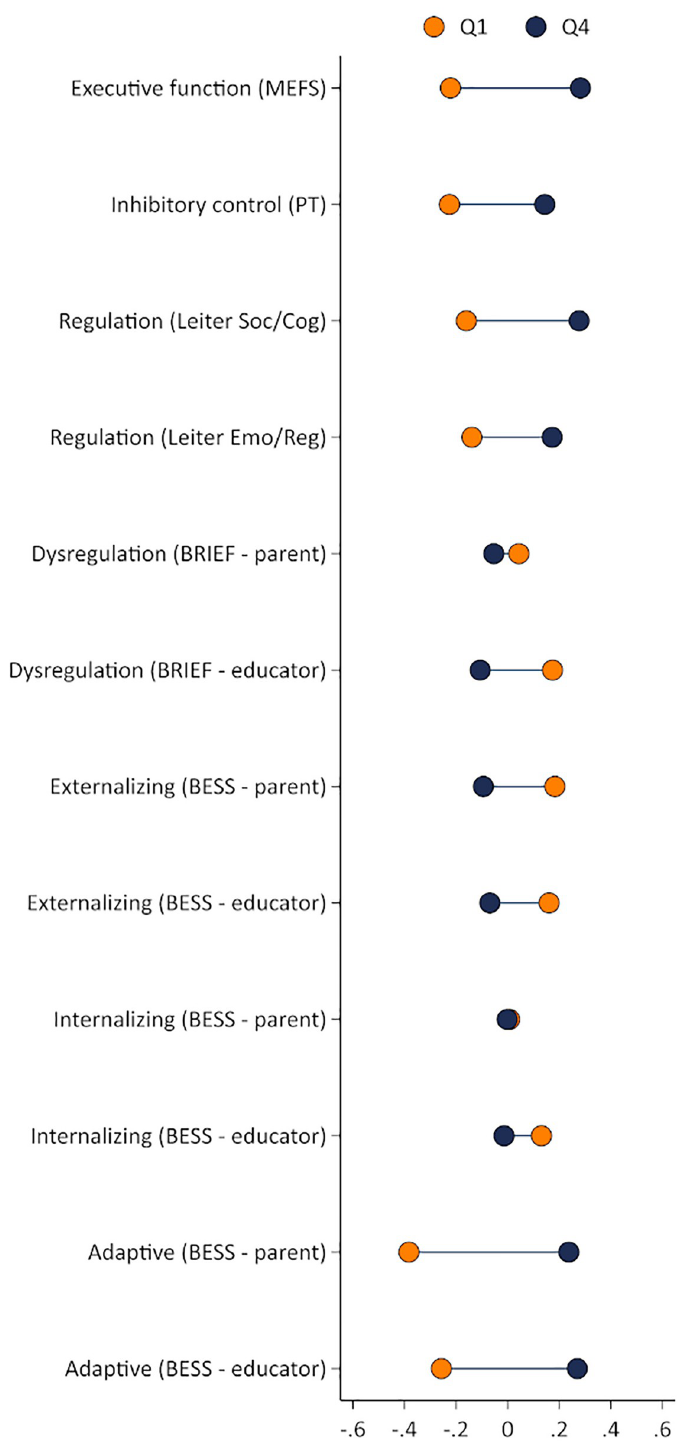
Fig 1. Average standardized score for SES quartiles 1 and